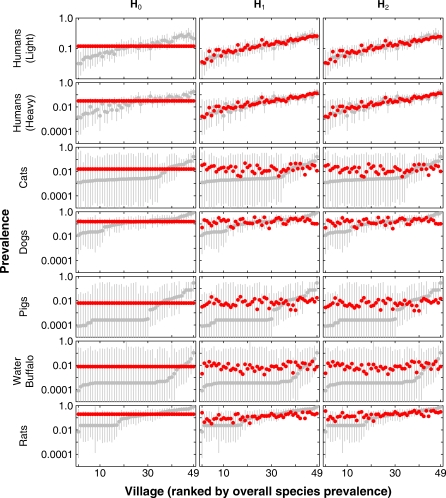
Comparison of Model (Red) and Observed (Grey) Prevalence Under Different Hypotheses for Two Classes of Human Infection and Five Potential Animal Reservoir SpeciesHypotheses were as follows. H
0 (no site-specific variability, left column), H
1 (site specific variability in process of infection from mammals to snails, centre column), and H
2 (site specific variability in process of infection from snails to mammals, right column). Each of the 49 villages is indexed (x-axis) according to the prevalence of infection for each particular species, i.e., the ordering of villages is different for charts in different rows in this graph (other than top two rows). For humans (top two rows), the villages are indexed according to estimated overall prevalence. Grey points show the observed prevalence, adjusted jointly for the sensitivity and specificity of parasitological tests and the number of stool samples provided per participant. Binomial confidence intervals are presented for these adjusted data. The red points show the maximum likelihood steady-state values for the transmission model.